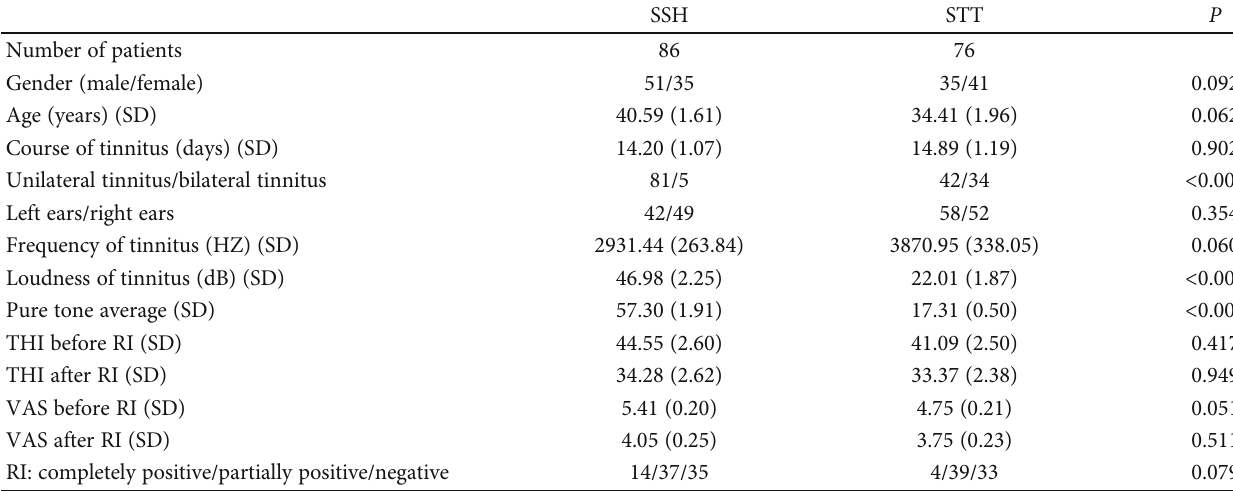
Table 1: The basic information of SSH and STT ( n = 162